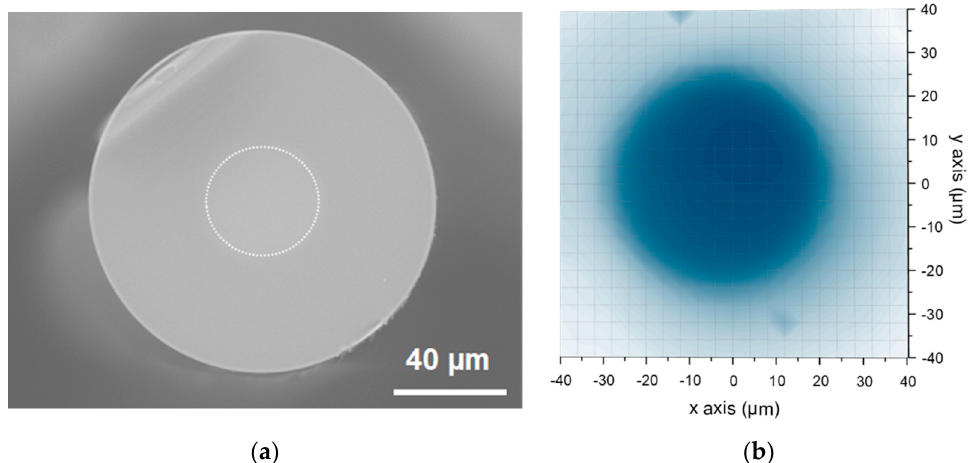
Figure 5. ( a ) SEM image of cross-section of the drawn fiber (the Ce-doped zone has been indicated by a white dashed circle), ( b ) Experimental mapping response of the Ce luminescence distribution along the fiber transverse cross-section: a laser excitation at 325 nm and a spatial step of 2.5 µm.